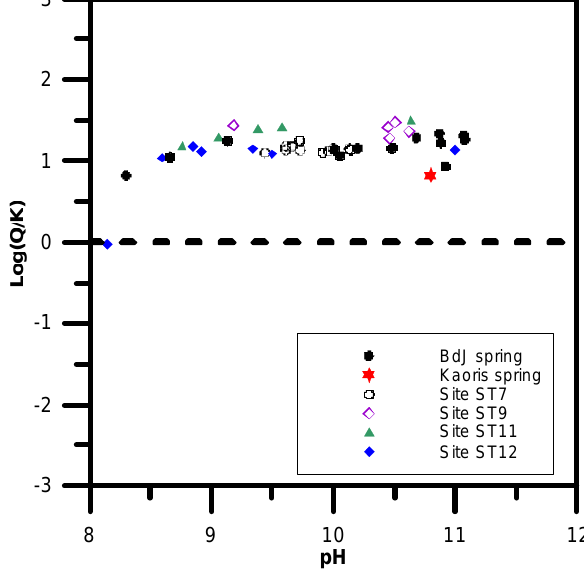
Figure 9. The calcite saturation state of the Prony Bay waters ver- sus pH. Same symbols as for Fig. 5. The horizontal dashed line represents the chemical